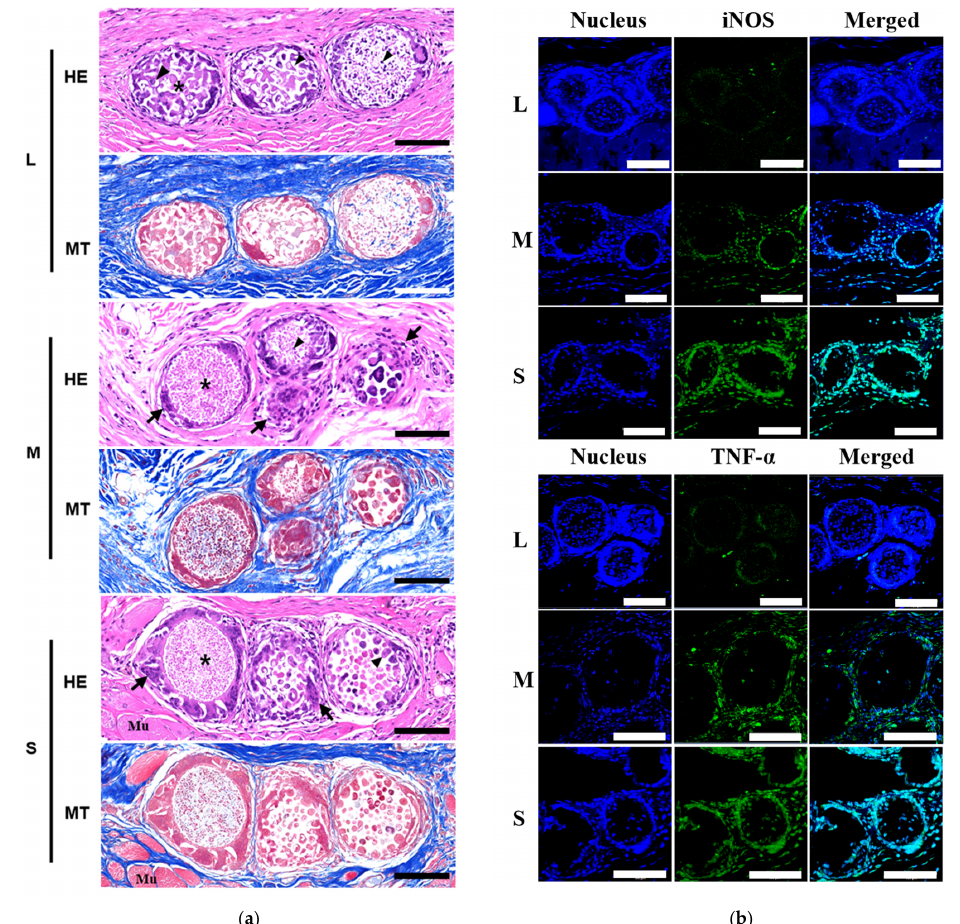
Figure 6. ( a ) Histological images of in vivo biocompatibility analysis for highly porous microspheres. The 3 different types of porous PCL microspheres (L, M, and S) were injected into the subcutaneous tissue of rats for 4 weeks and harvested after 4 weeks. *: PCL porous microspheres. Arrows: Inflam- matory cells. Arrowheads: Cells infiltrated in PCL porous microspheres. Mu: The muscle tissue. HE: Hematoxylin–eosin staining. MT: Masson trichrome staining (Scale bar: 50 µ m). ( b ) Immunofluo- rescence microscopic images of inflammation-related protein (iNOS and TNF- α ) expression in the subcutaneous tissue of rats injected with highly porous PCL microspheres (scale bar: 100 µ m). Further, we performed immunohistochemical staining for the expression of inflammation- related markers, iNOS, and TNF- α , in the microsphere-implanted rat tissue matrix to